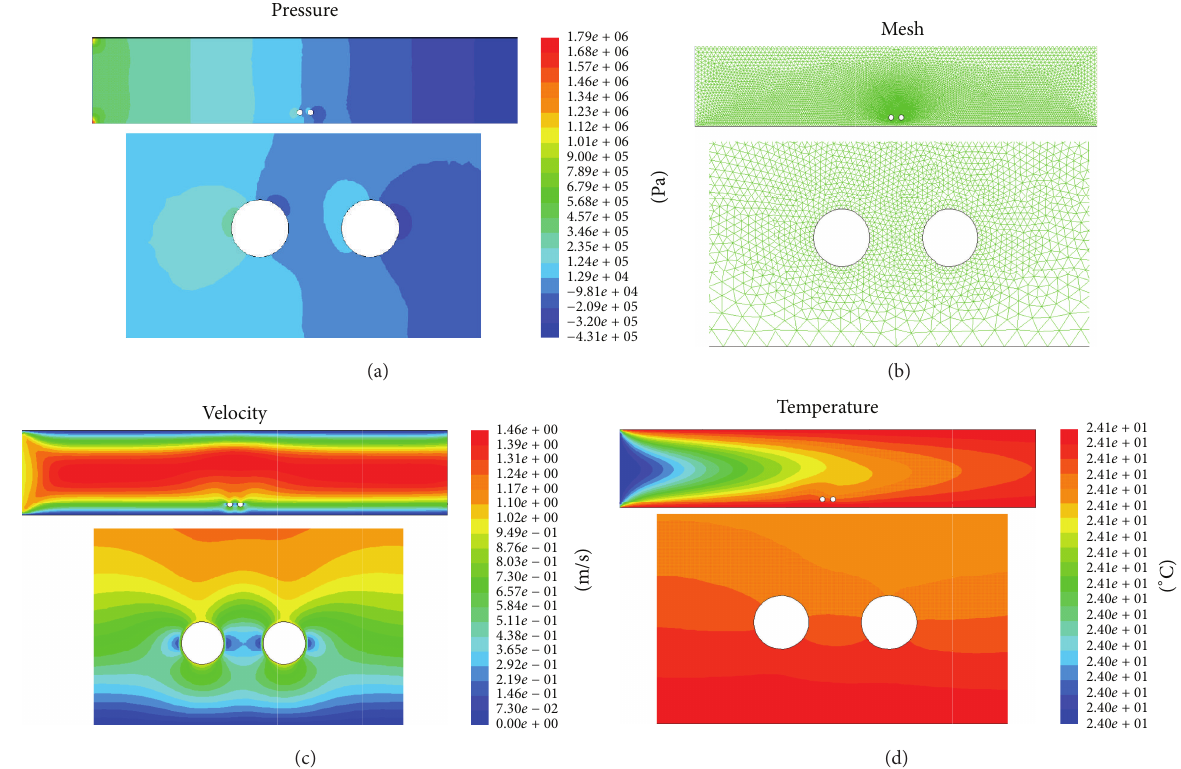
Figure 7: Case 3, velocity, temperature, pressure gradient, and mesh model (time =